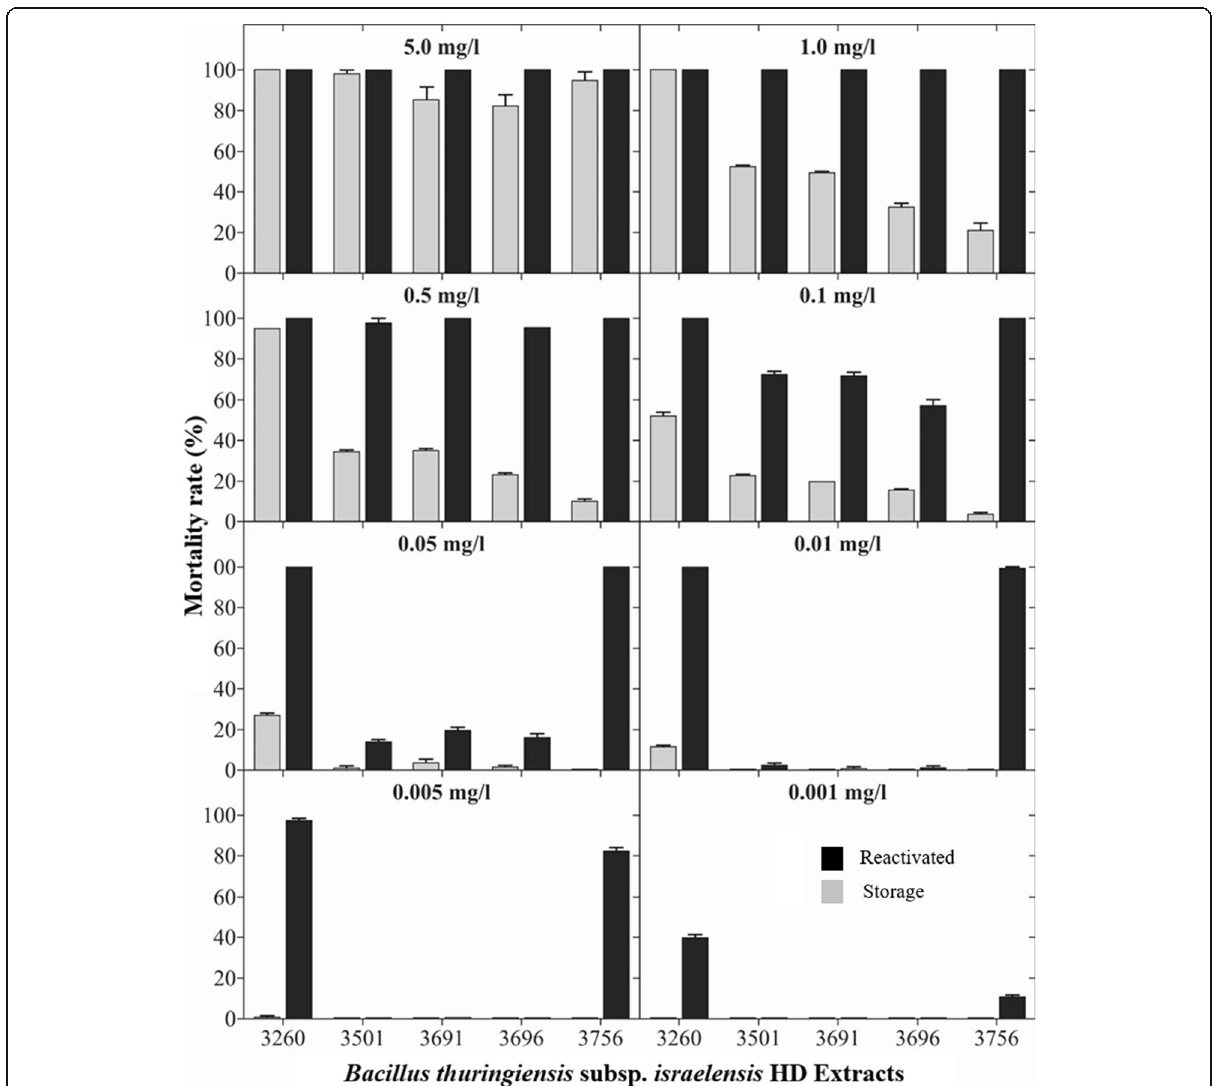
Fig. 1 Mortality percentage of Aedes aegypti larvae exposed to different HD extracts concentrations from Bacillus thuringiensis subsp. israelensis